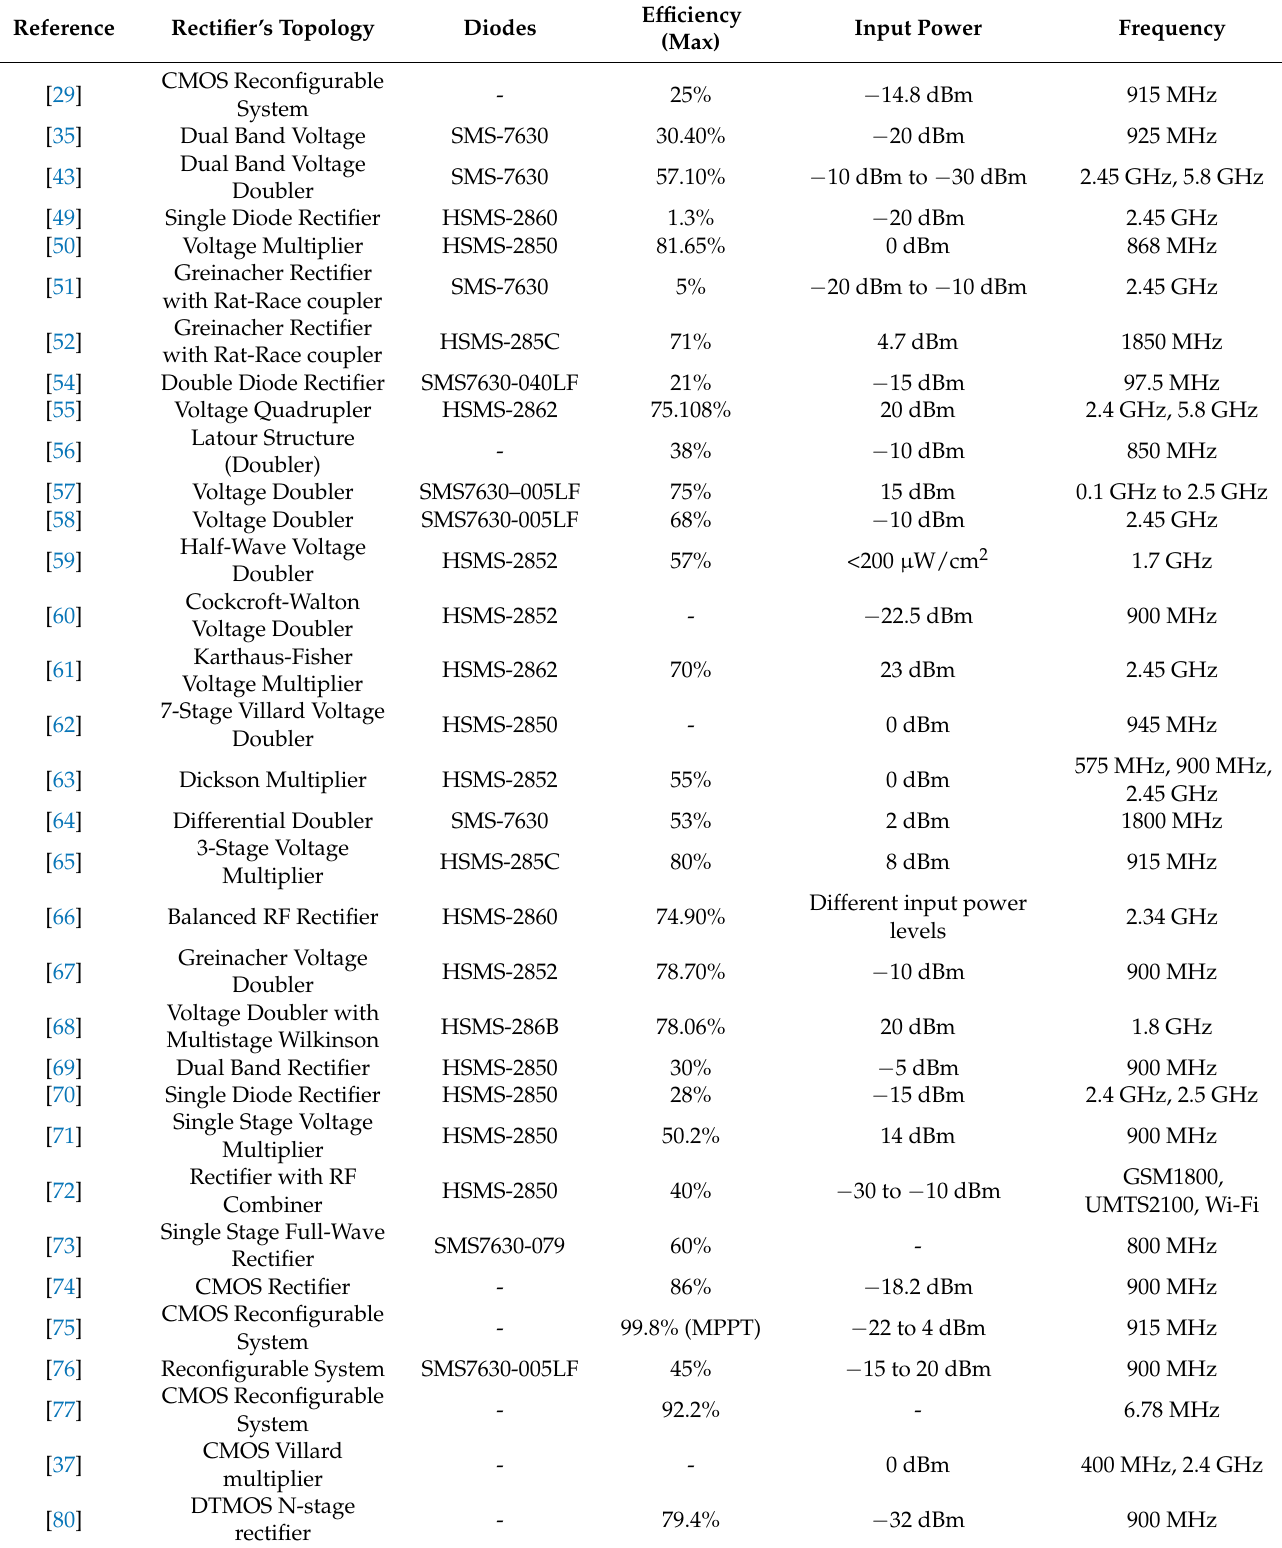
Table 5. Different rectifier circuits in